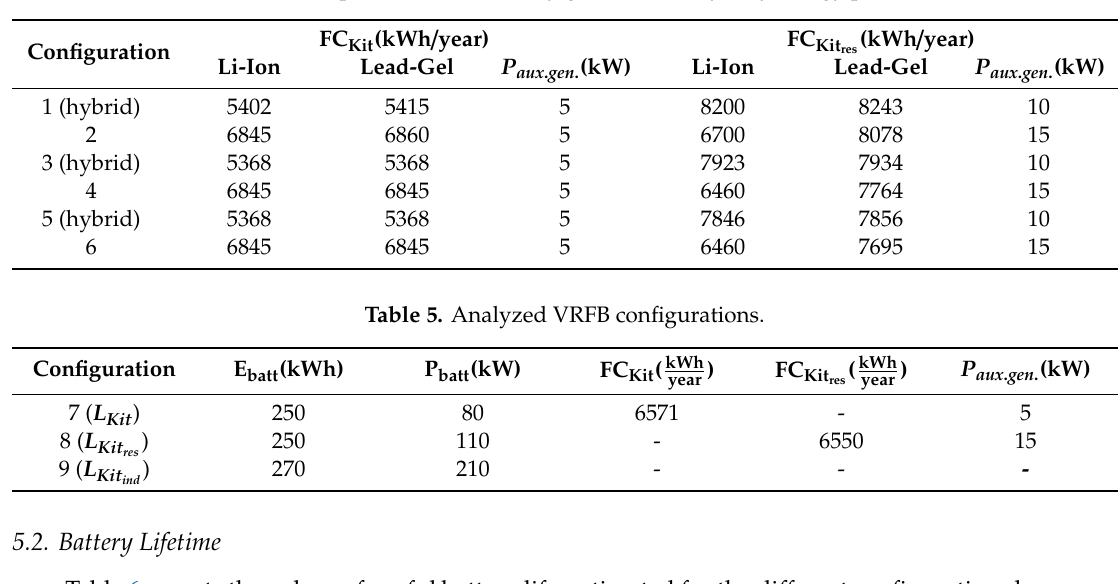
Table 4. Installed power of the auxiliary generator and yearly energy production.